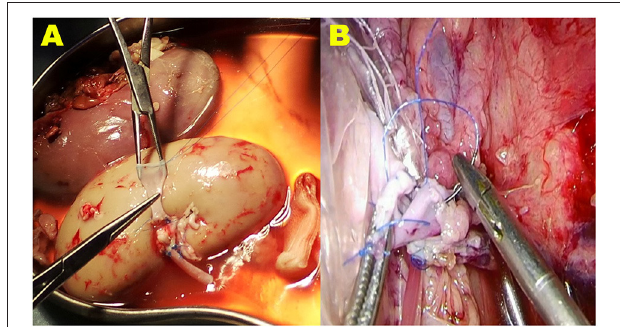
FIGURE 3 | The vein beltization technique used for vein anastomosis in the VB group. (A) The broken end of the donor renal vein is circumferentially sutured with a 5-0 Prolene suture material at a distance of 2.0cm from the edge. When the knot is tied, the vein is braced with forceps. This circumferential circle of Prolene sutures can widen the vein to its maximal size. (B) During the operation, when tightening the suture material and tying the last knot to finish the anastomosis, the ends of the Prolene suture material are carefully pulled; however, avoiding a purse-string effect at the anastomosis stoma of the vein is